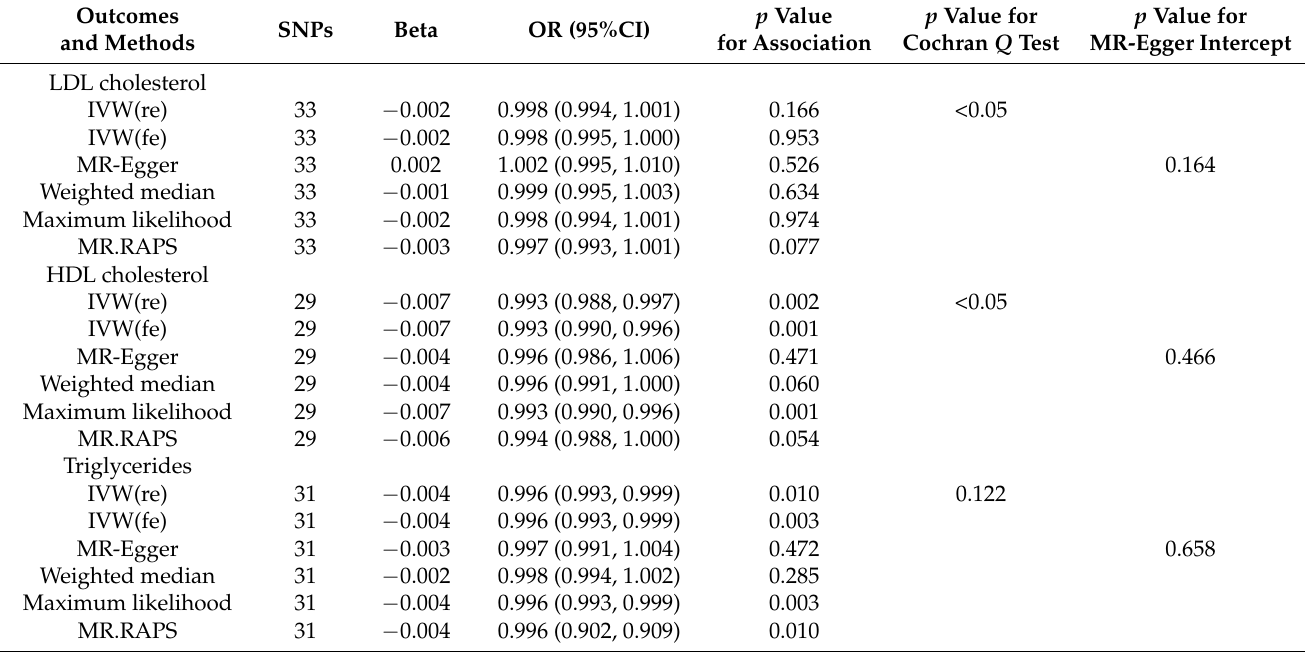
Table 2. Two-sample Mendelian randomization of SLE and the risk of blood lipid